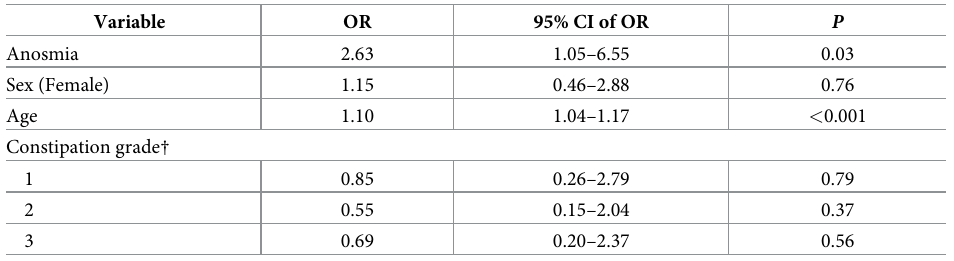
Table 2. The odds ratio of variables associated with cognitive dysfunction (MoCA < 26).